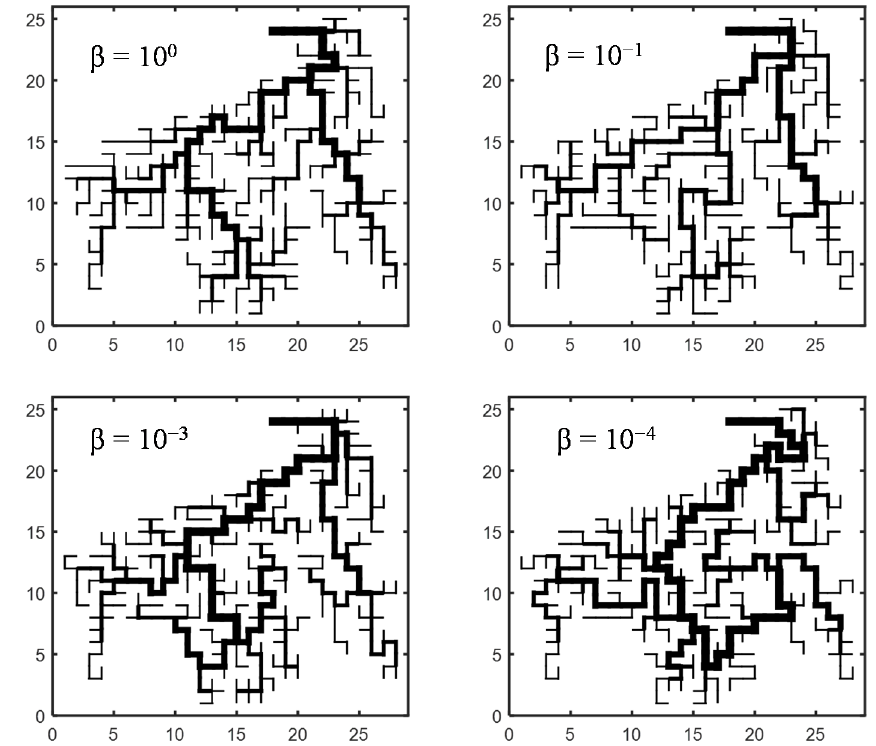
Figure 1. Gibbs’ model generated for a test catchment, Seocho4 for each β with a grid size of 50 m. The horizontal and vertical axis denote distance by number of